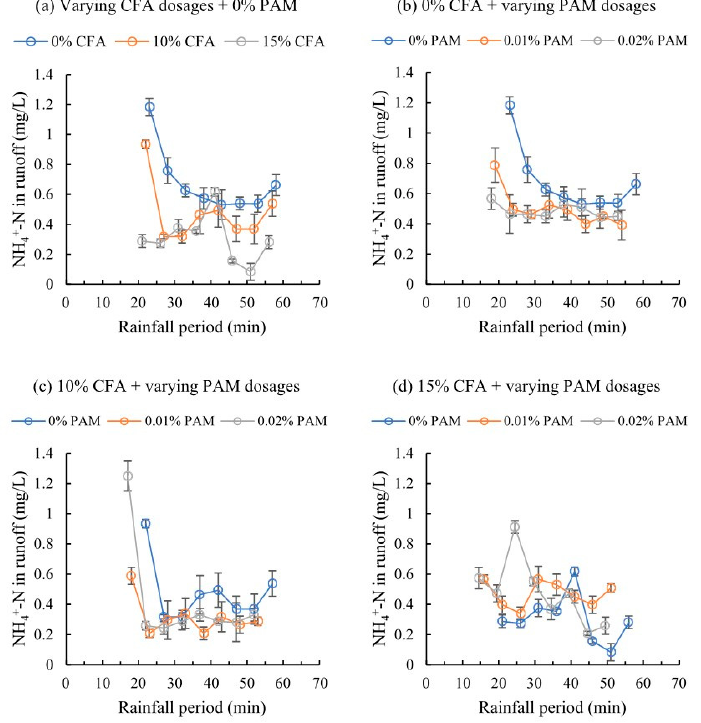
Figure 3. Variations in instantaneous NH 4+ -N concentration in runoff with rainfall period for varying CFA dosages + 0% PAM ( a ), 0% CFA + varying PAM dosages ( b ), 10% CFA + varying PAM dosages ( c ), 15% CFA + varying PAM dosages ( d ).